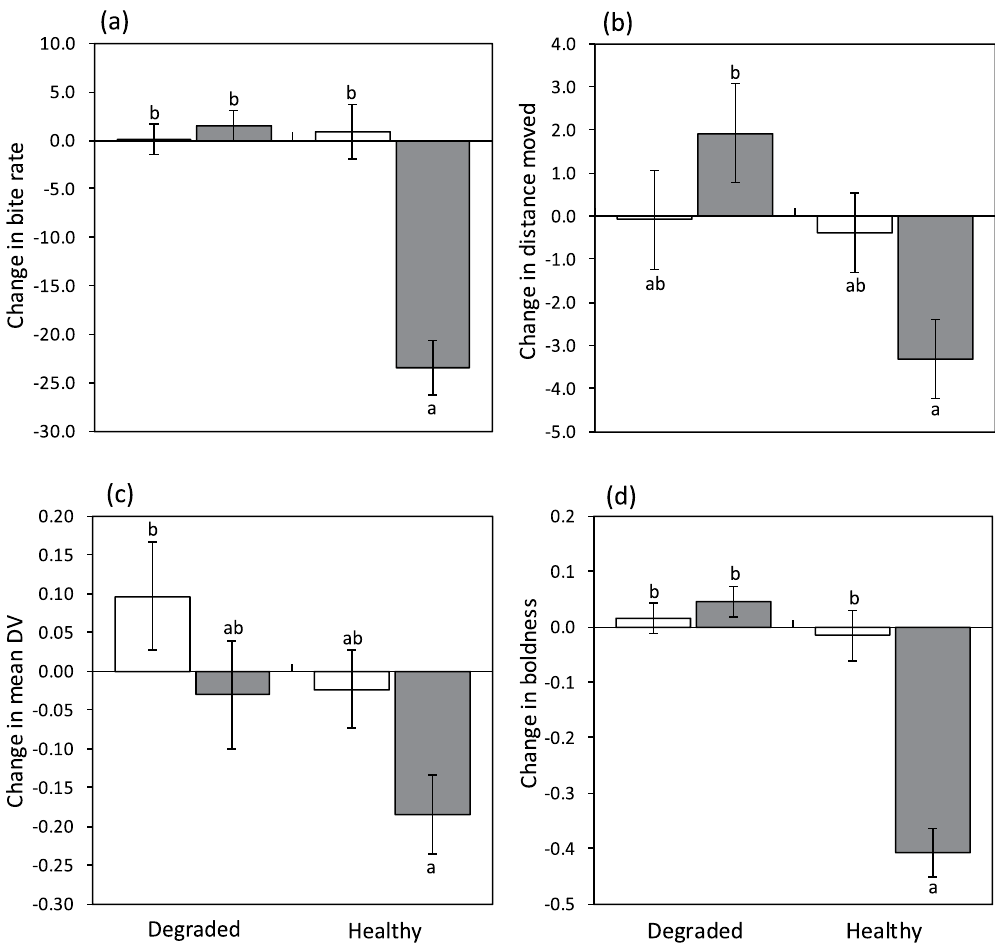
Figure 3. Change in bite rate ( a ), total distance moved ( b ), mean distance ventured ( c ) and boldness index ( d ) (means ± SE) for the Ambon ( Pomacentrus amboinensis ) exposed to either seawater (white) or conspecific alarm odour (grey) while residing on firstly a patch of dead-degraded coral, and then a patch of healthy live coral for 20–40 min. Change is calculated as ‘after’ subtracted from ‘before’ the injection of the cue. Lowercase letters above error bars represent Tukey’s HSD means comparisons. N (from left) = 15, 21, 15, 21.